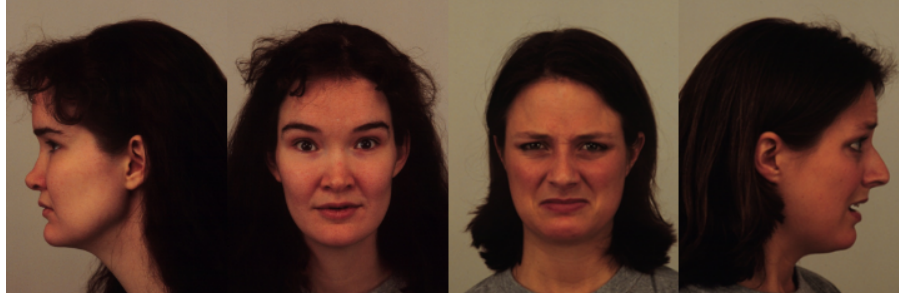
Figure 1. Example images taken from the KDEF dataset [47].